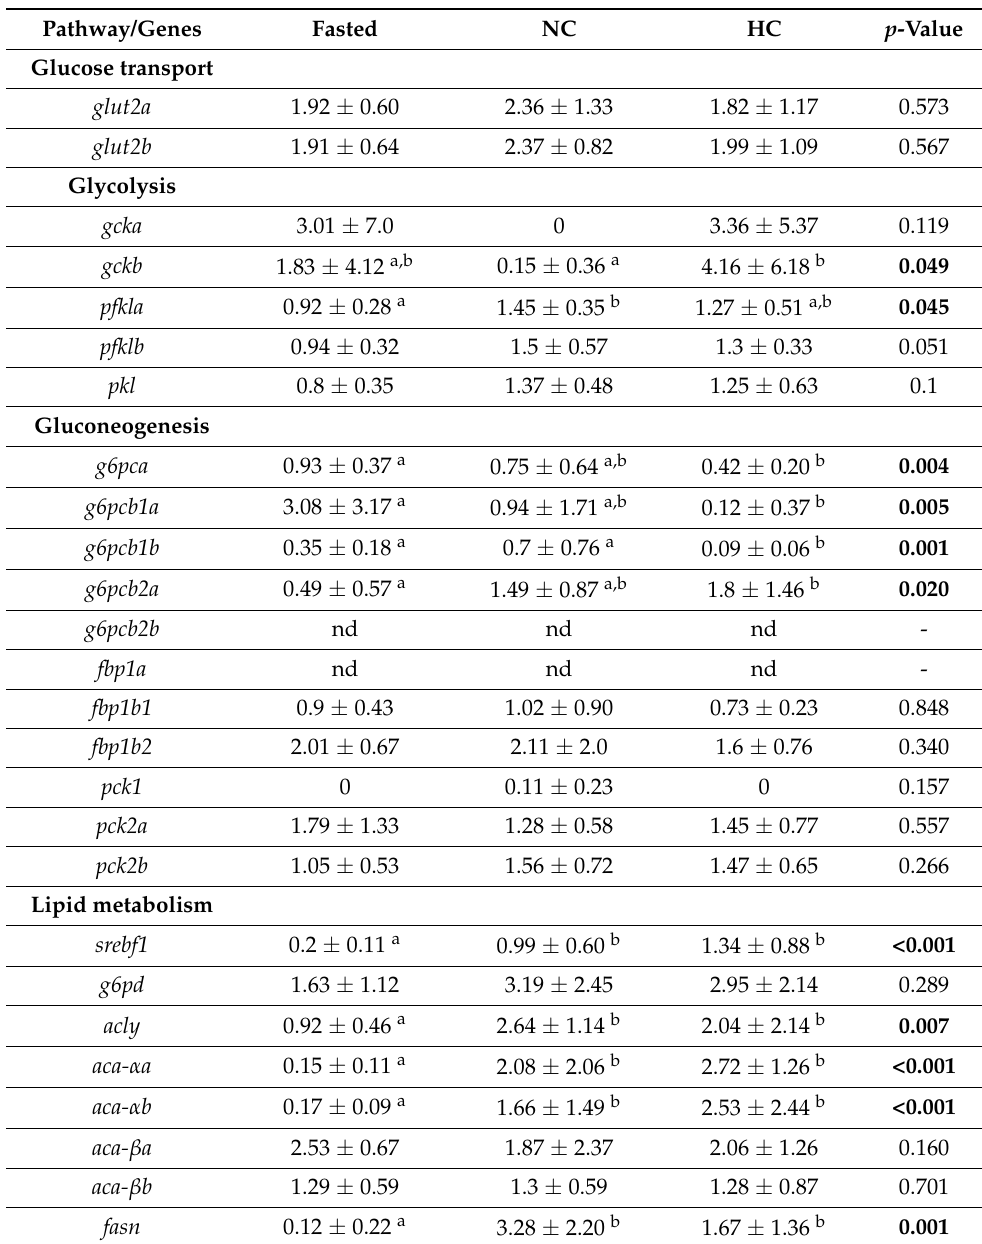
Table 1. Relative mRNA levels of glucose and lipid metabolism-related genes in liver of fasted mature female rainbow trout, fed with a non-carbohydrate diet (NC) or fed with a high-carbohydrate diet (HC). Data are represented as means ± SD ( n = 9 females per condition). Genes which have not been detected are represented by “nd”.Data were analysed using one-way ANOVA when conditions of application were respected, otherwise the Kruskal–Wallis test was performed. Significant differences of means were analysed using post hoc Tukey’s test and are represented using different letters ( a , b ) and bold p